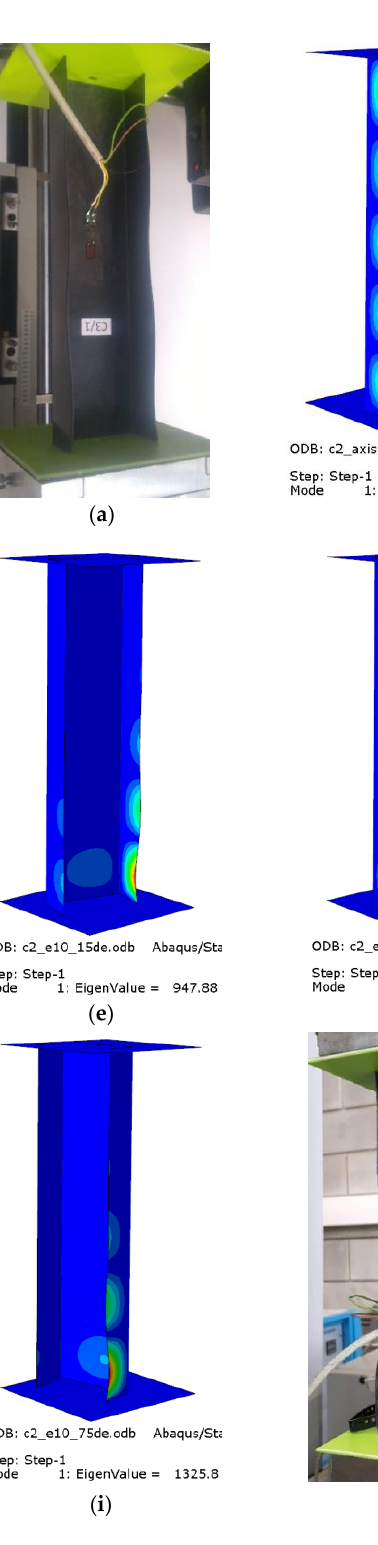
Figure 8. Buckling modes for C1 [0/45/ − 45/90] s : ( a ) axis EXP, ( b ) axis FEM, ( c ) e10_0° EXP, ( d ) e10_0°